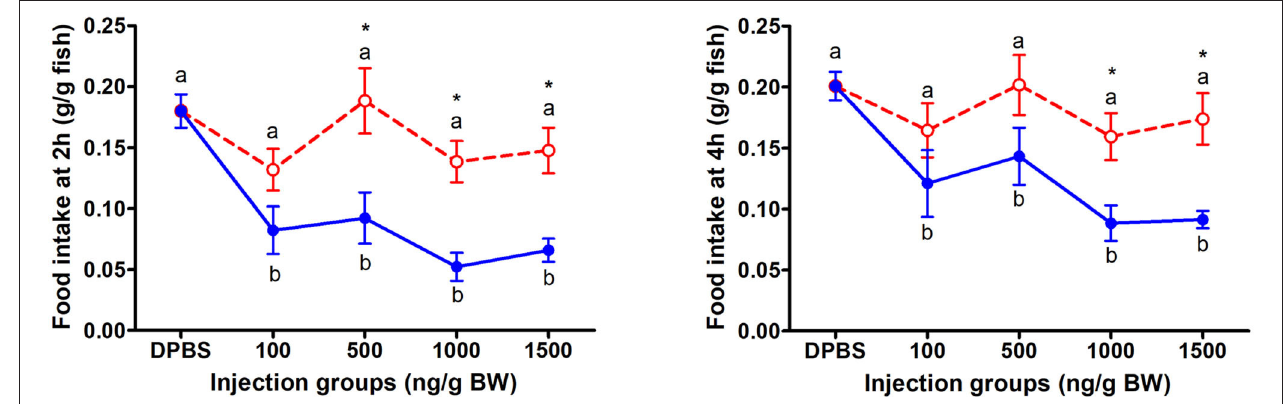
FIGURE 1 | The effects of intraperitoneal administration of LepA (red dotted line) and LepB (blue solid line) on food intake at 2 and 4h. Data represent means ± S.E.M ( n = 6). Significance level are marked with different letters ( P < 0.05), compared with the values from DPBS injected mandarin fish. Mean values with an asterisk (*) above show significant differences between fish groups injected with leptin A and leptin B at the same dose ( P <